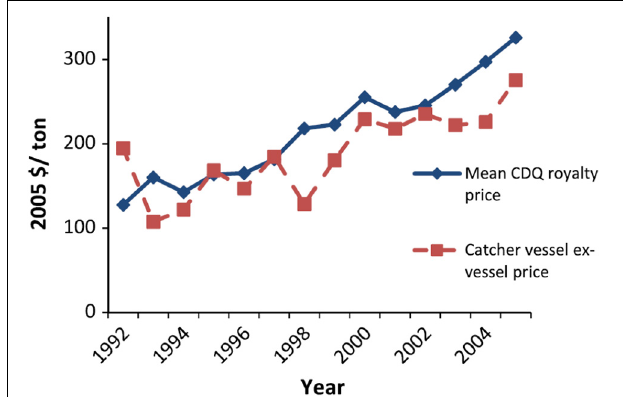
FIGURE 2 | Annual CDQ royalty rates and inshore catcher vessel ex-vessel prices of the Alaska pollock fishery expressed in inflation-corrected (to the year 2005) US$/t of pollock (Haynie,